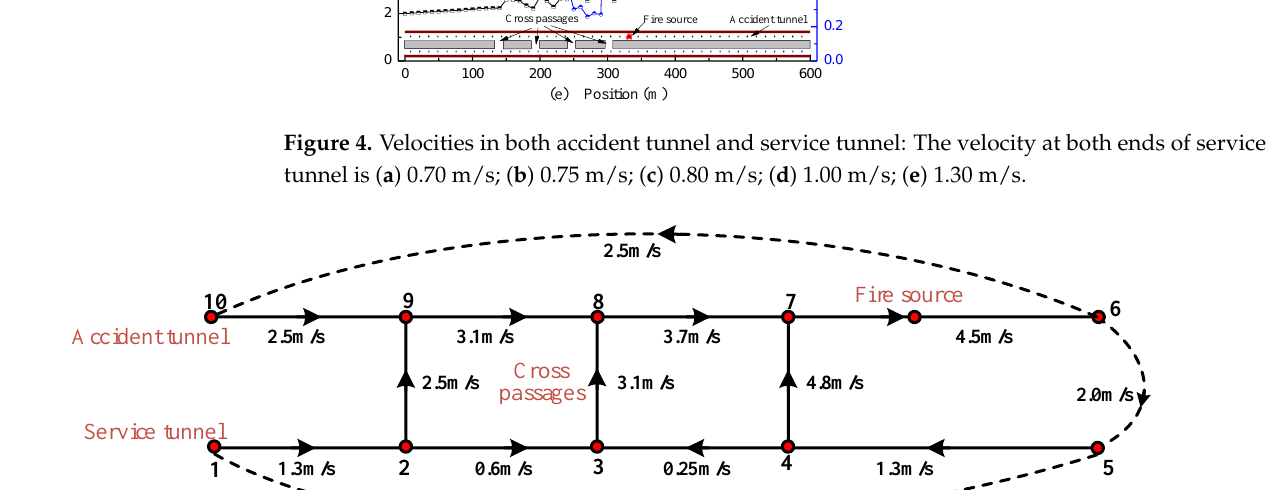
Fire 2022 , 5 , x FOR PEER REVIEW 8 of 10